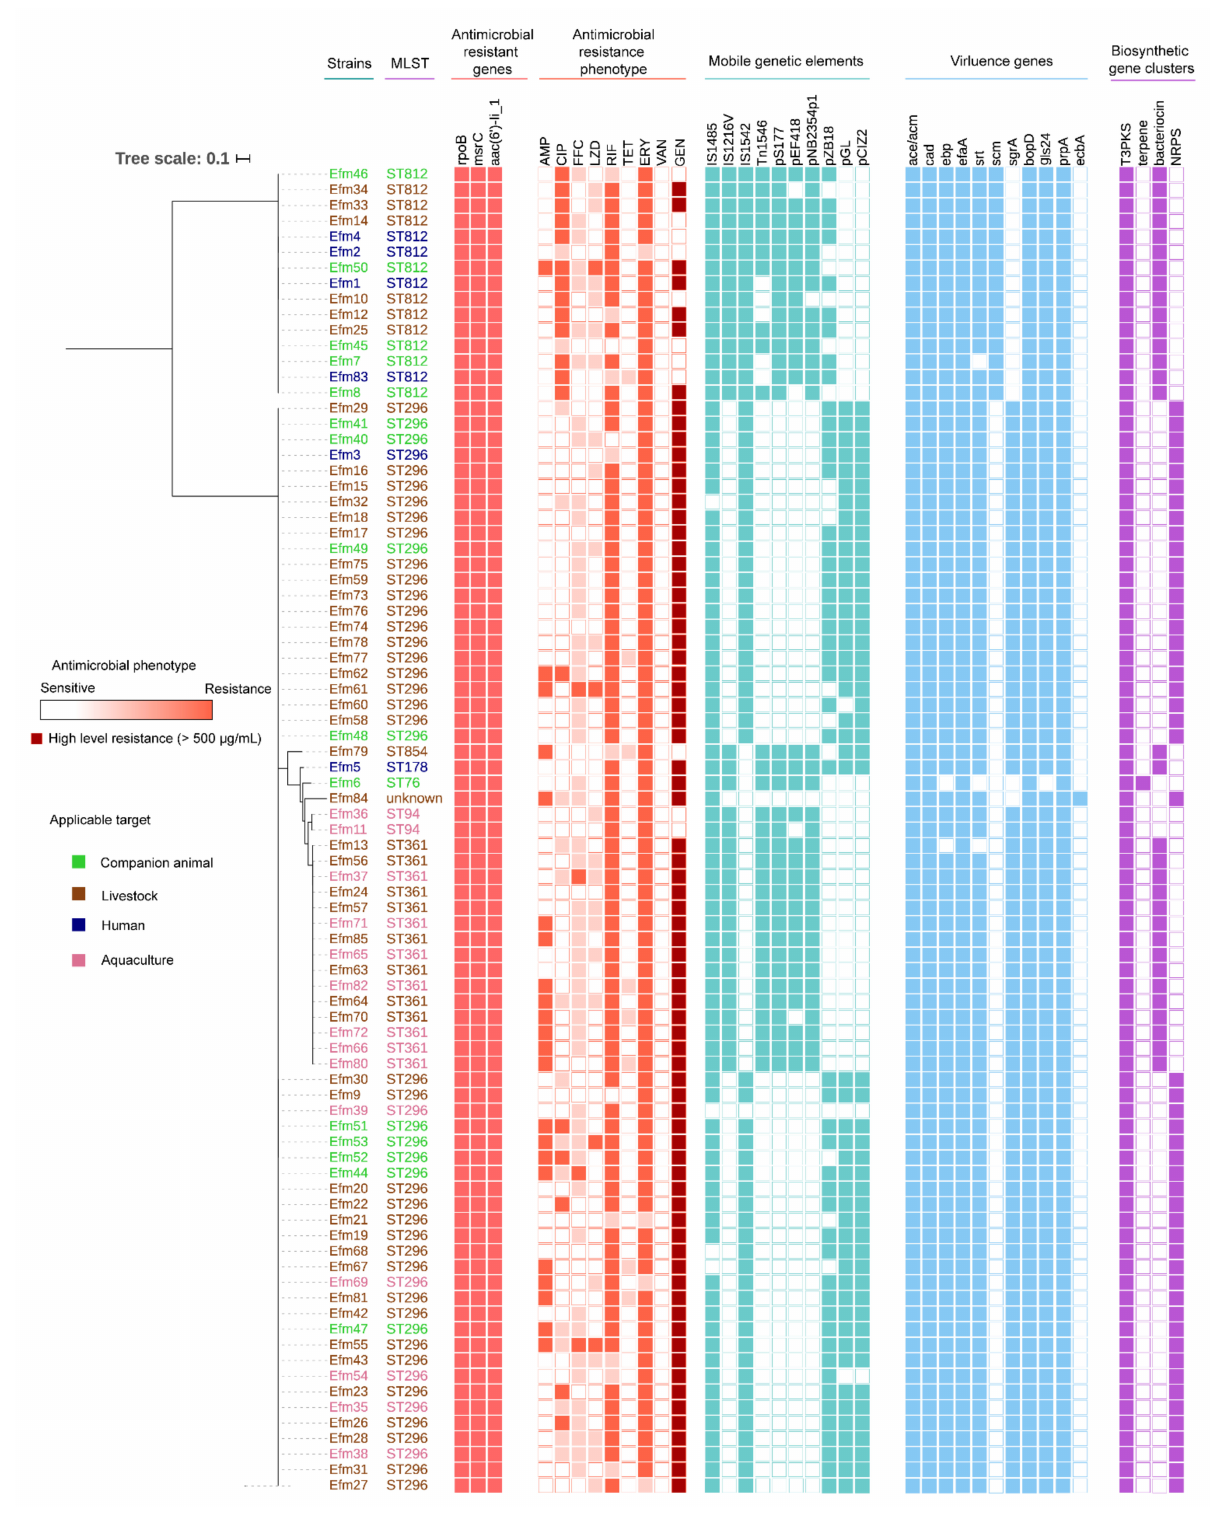
Figure 2. Phylogenetic tree and multilocus sequencing types, antimicrobial resistance genes (ARGs) and phenotype, mobile genetic elements (MGEs), virulence genes (VGs), and biosynthetic gene clusters (BGCs) among enterococcal isolates from probiotic products. The sources of the isolates are differentiated by color. Filled squares are for presence and empty squares are for